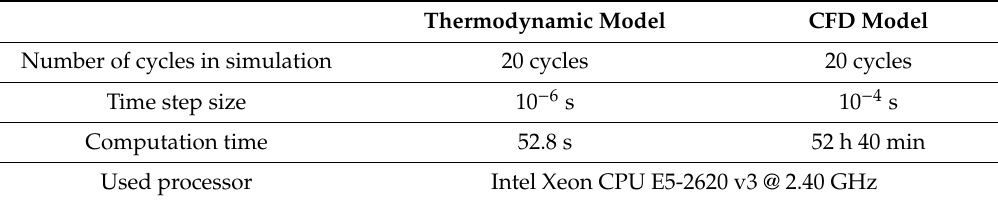
Table 3. Consumed computation time by thermodynamic and CFD models.